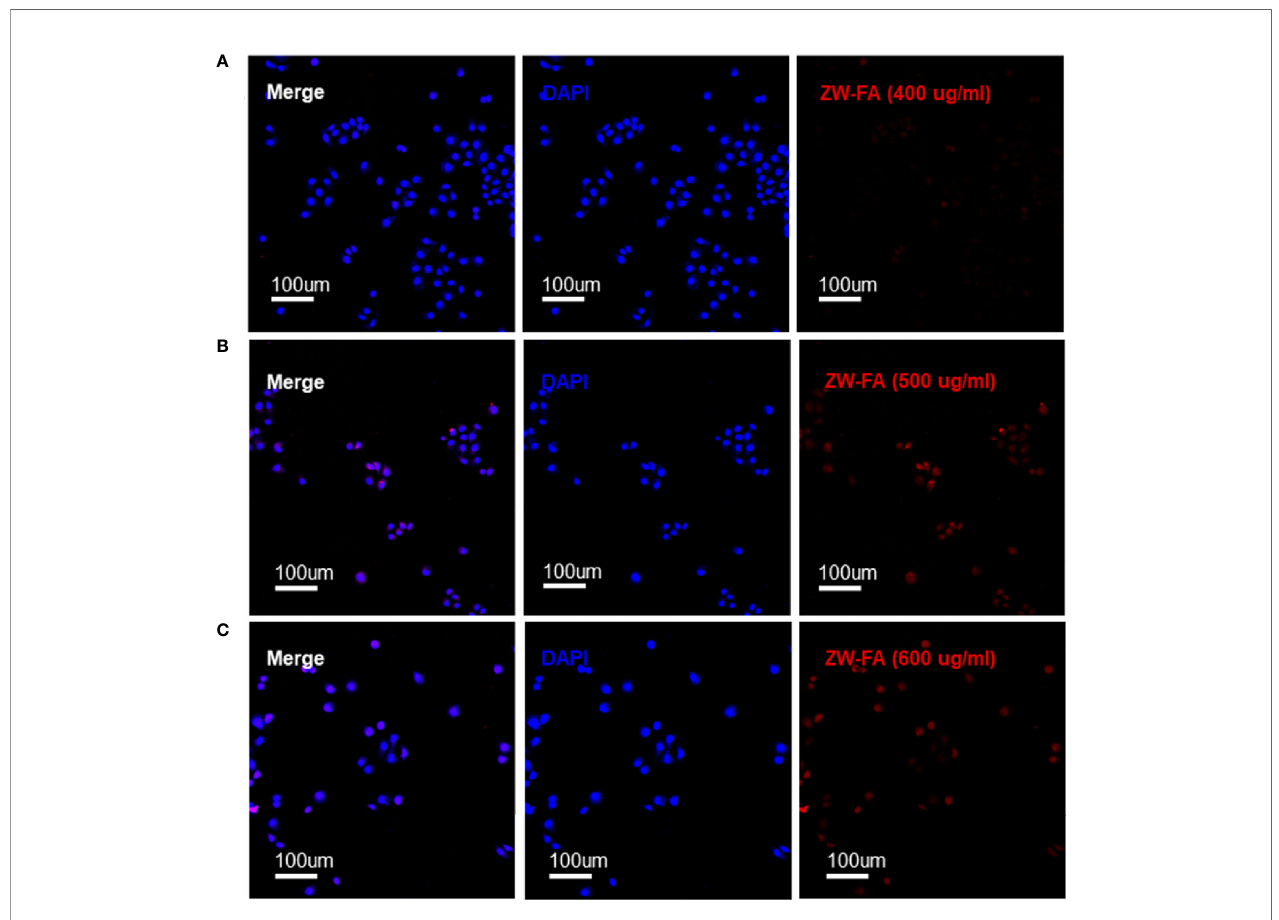
FIGURE 3 | Fluorescence images of SKOV 3 incubated with ZW-FA in gradient concentration. (A) Fluorescence images of SKOV 3 , cells were incubated with ZW-FA in 400 ug/ml and DAPI in sequence. (B) Fluorescence images of SKOV 3 , cells were incubated with ZW-FA in 500 ug/ml and DAPI in sequence. (C) Fluorescence images of SKOV 3 , cells were incubated with ZW-FA in 600 ug/ml and DAPI in